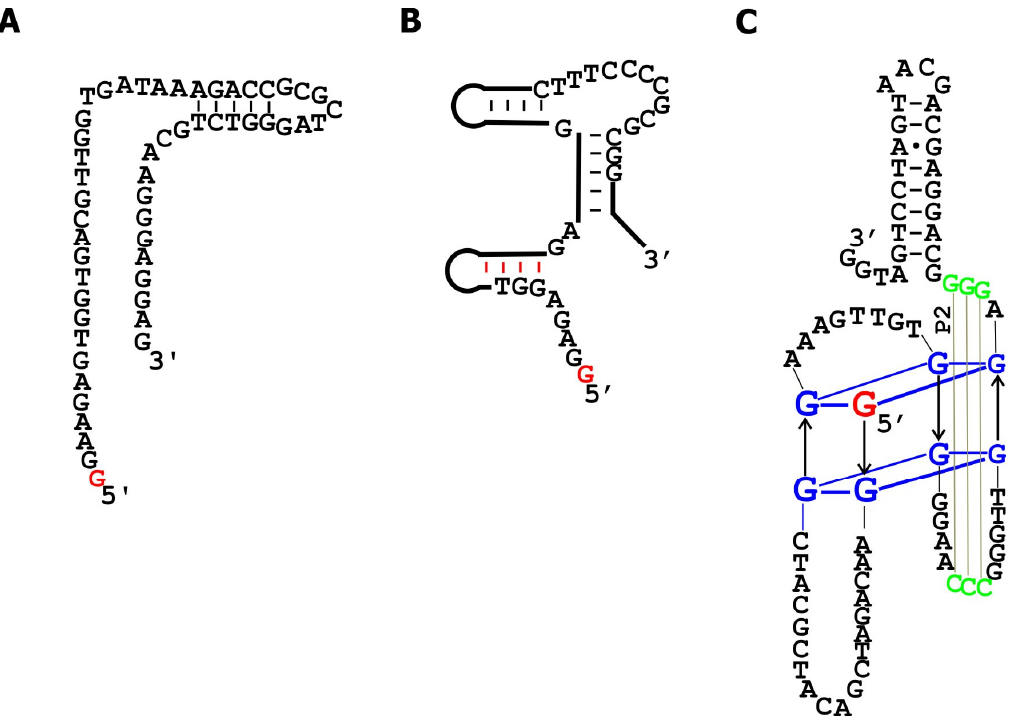
Figure 4. Structure diversity of kinase (self-phosphorylating) deoxyribozymes. (A) Structural model of Dk1, an ATP-utilizing kinase deoxyribozyme. Dk1 contains a central stem flanked by two unstructured regions. The site of self-phosphorylation is shown in red. (B) Secondary structural model for GTP-utilizing kinase deoxyribozymes Dk2, Dk3, and Dk4. Red lines indicate base-pairs that are present in Dk3 and Dk4 but not Dk2. (C) Structural model of Dk5, an ATP and GTP utilizing kinase deoxyribozyme. The structure contains a two-tiered guanine quadruplex shown in blue. A three base-pair stem (shown in green) forms a pseudoknot interaction with the